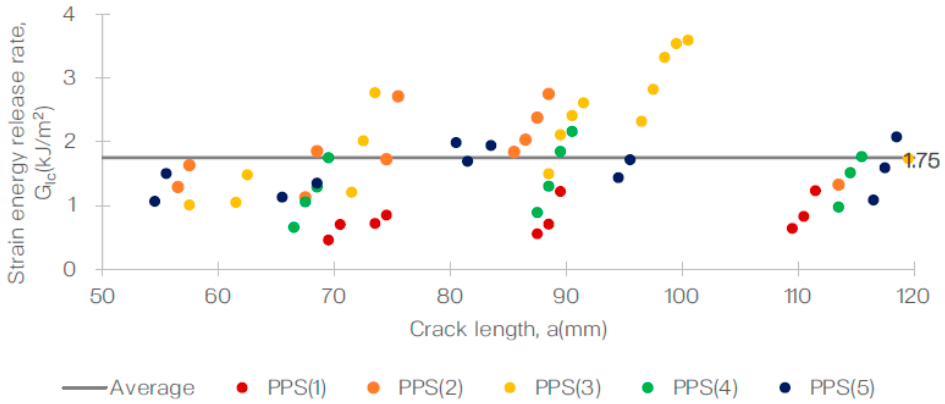
Figure 6. Delamination resistance curve (R-curve) from the DCB test of the T700/PPS system.